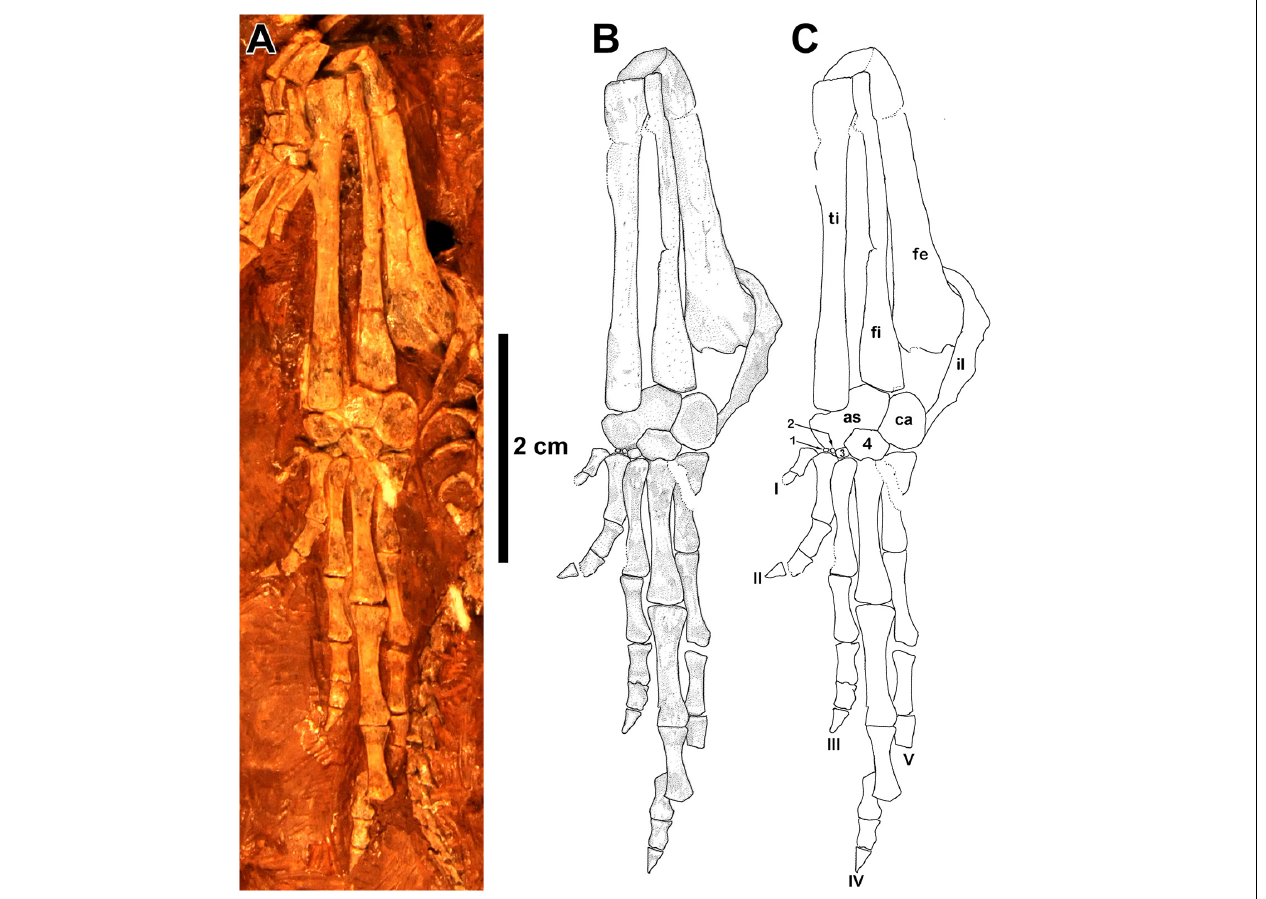
FIGURE 7 | Eudibamus cursoris , holotype (MNG 8852). (A) Photograph showing left hindlimb in dorsal view except for ventral view of femur. (B) Illustration and (C) outlines of labeled elements of femur, crus, and